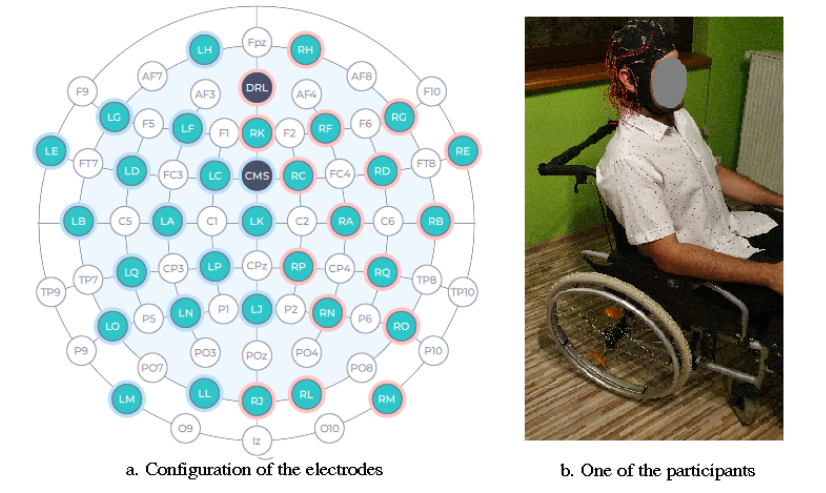
Figure 1. Presentation of electrodes configuration and one of the participants during the